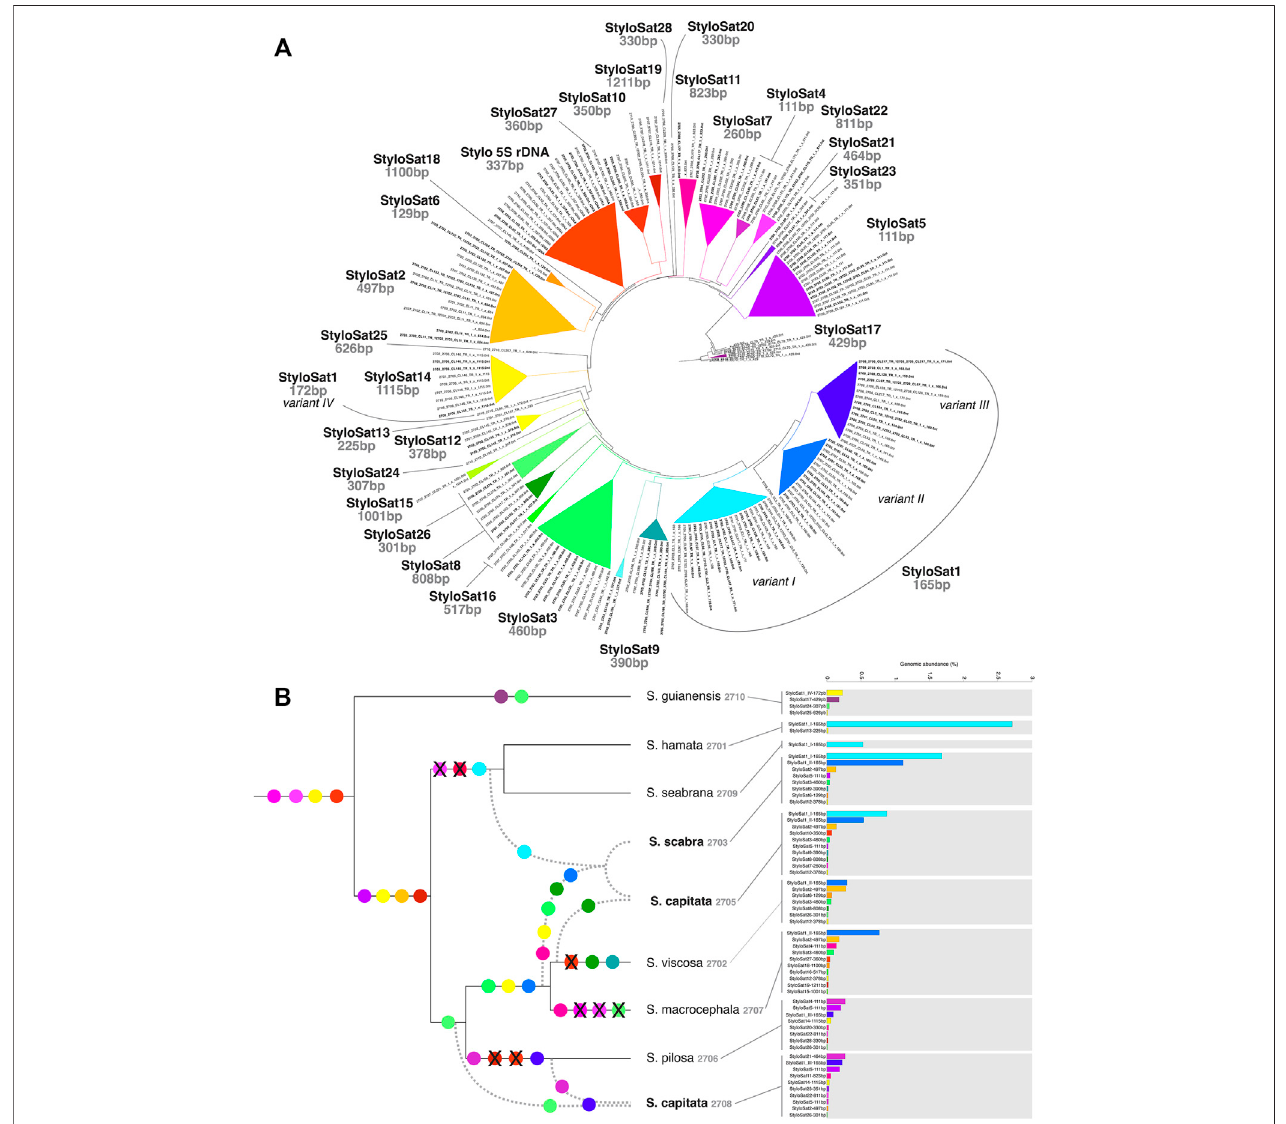
FIGURE6| Satellitomecharacterizationof Stylosanthes . (A) AAFtreeshowingthegroupingofalldifferentsatDNAfamiliesfoundin Stylosanthes .StyloSat1familyis themostabundantandshowsspeci fi clineagesimilarity,whichisconservedinallopolyploids. (B) OverviewofsatDNAshowingmorethan0.01%ofgenomicabundance ineachsampleidenti fi edbyTAREAN.SatDNAconsensusofeachsampleobtainedbyTAREAN/RepeatExploreranalysiswereusedasreferencetoretrieverepeatreads mapped uniquely to each consensus. The draw tree re fl ects the most parsimonious species relationships based on all our analyses.